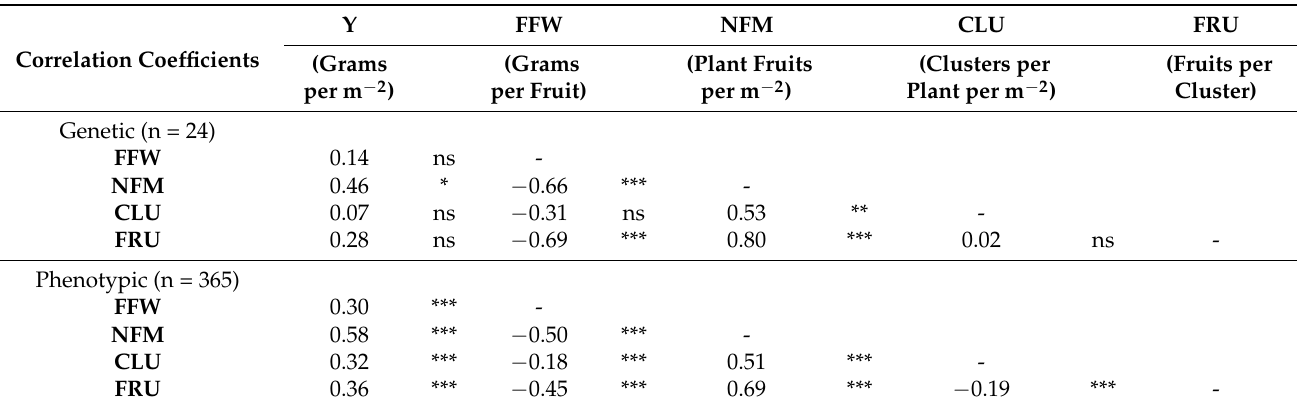
Table 3. Yield and yield component Spearman correlations. n =